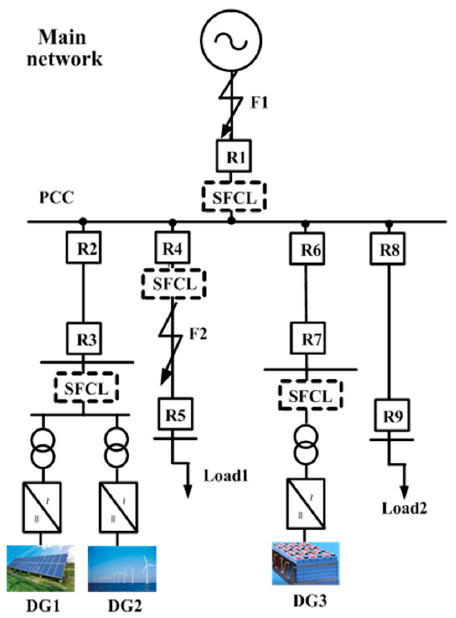
Figure 2. Schematic diagram of a typical micro ‐ grid integrated with the SFCLs. PCC, point of common coupling.